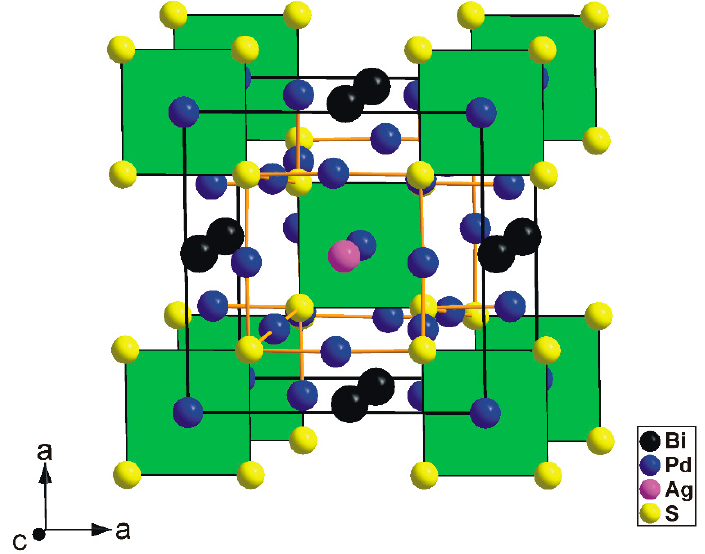
Figure 4. Crystal structure of thalhammerite showing the [PdS 4 ] squares and Pd–S bonds. Unit-cell edges are highlighted. Details show the Rietveld profiles of synthetic thalhammerite showing the weak peak splitting, which cannot be fitted using the tetragonal cell.